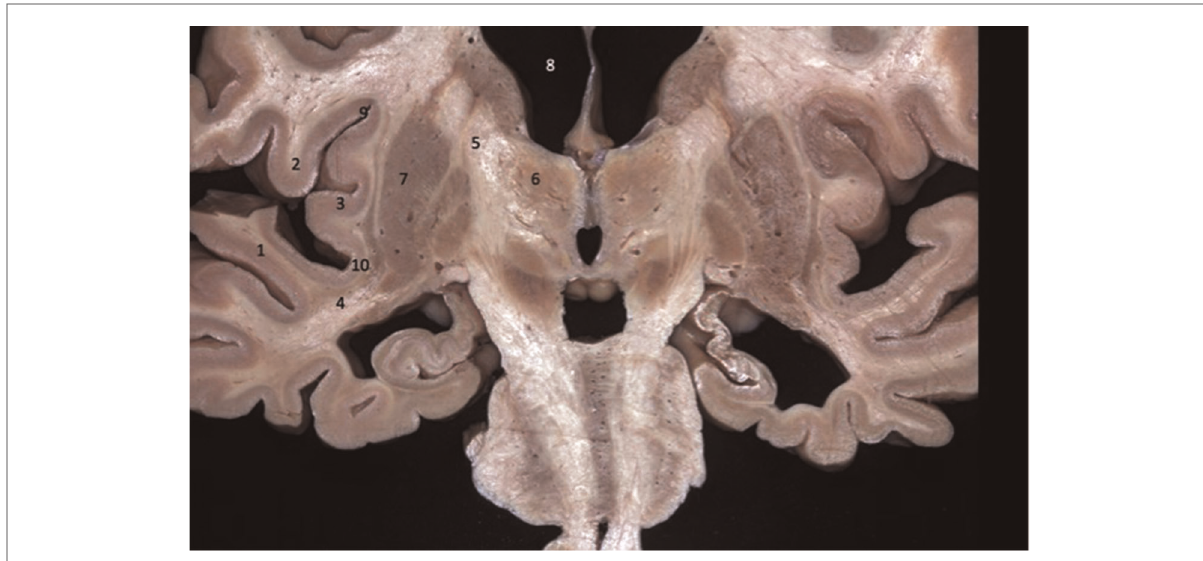
FIGURE 3 Coronal brain section showing the relations between the insula and the gyri of the sylvian fi ssure. The superior temporal gyrus (1) covers the lower half of the lobe of the insula while the inferior frontal gyrus (2) covers the upper half. 1 - superior temporal gyrus; 2 - inferior frontal gyrus; 3 - insular